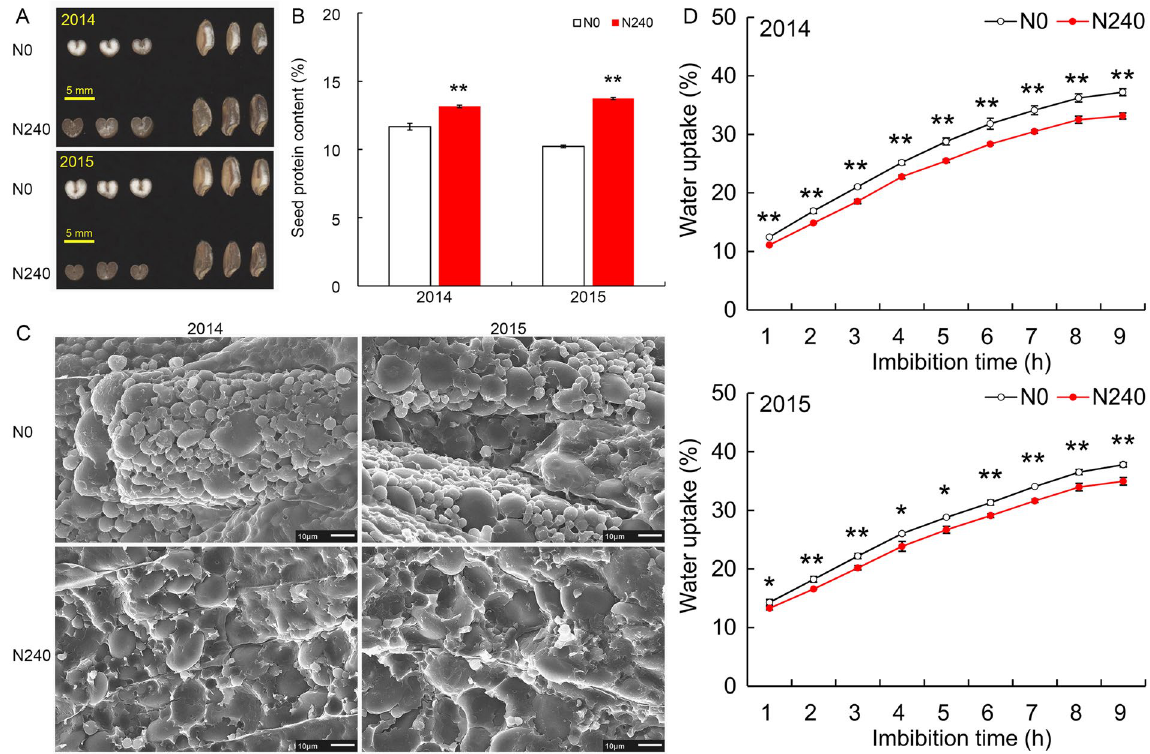
Figure 2. Effects of endosperm structure of seeds on water uptake. ( A ) Transverse section and longitudinal section of N0 seeds and N240 seeds. ( B ) Protein content of N0 seeds and N240 seeds. ( C ) Scanning electron microscope maps enlarging 1000 × endosperm structure of N0 seeds and N240 seeds. ( D ) Water uptake of seeds. Error bars represent the standard deviation for three replicates. Asterisks denote a significant difference according to unpaired Student’s t test ( * p ≤ 0.05; ** p ≤